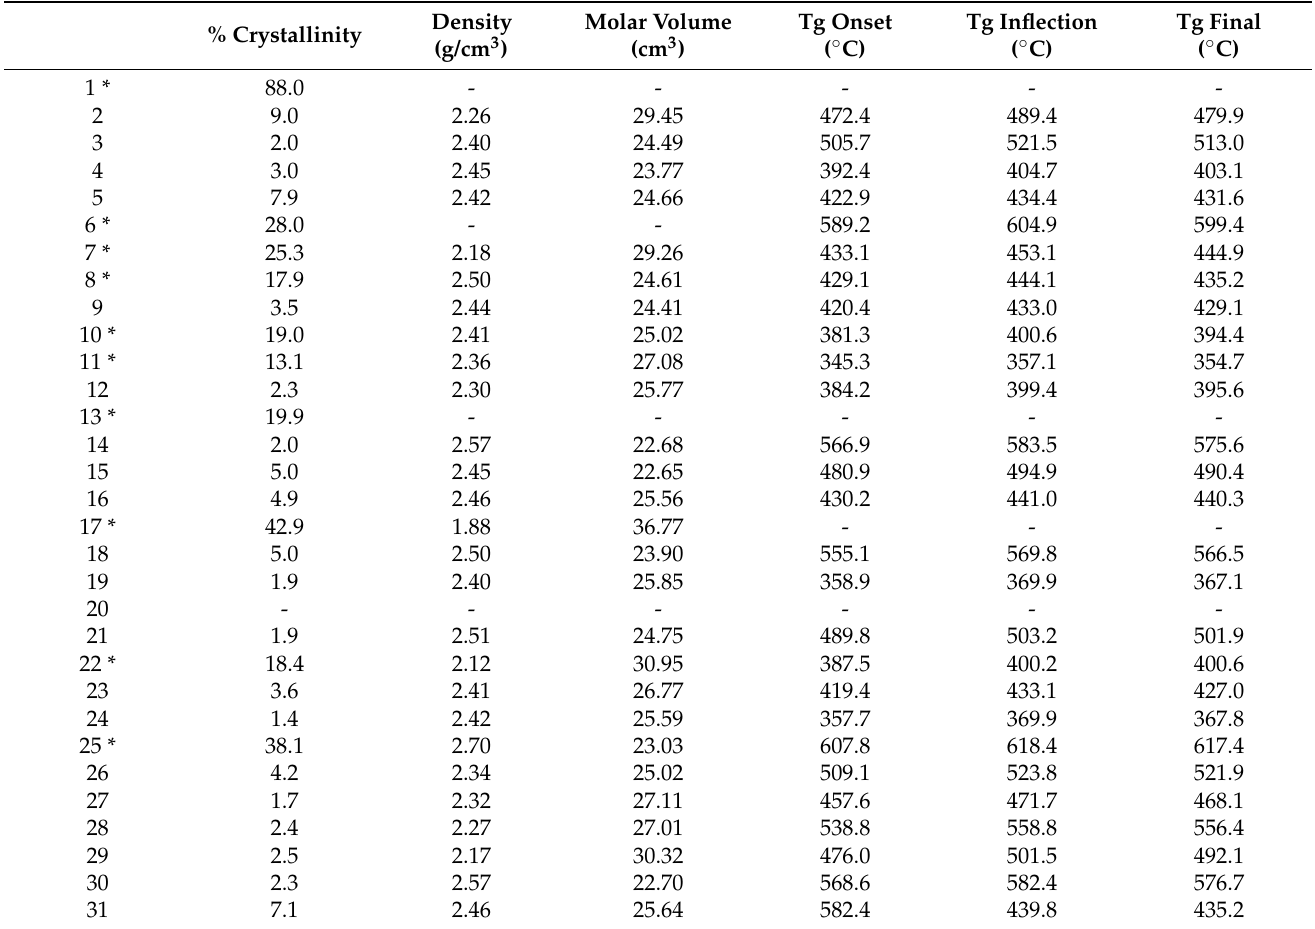
Table 3. The material characterization